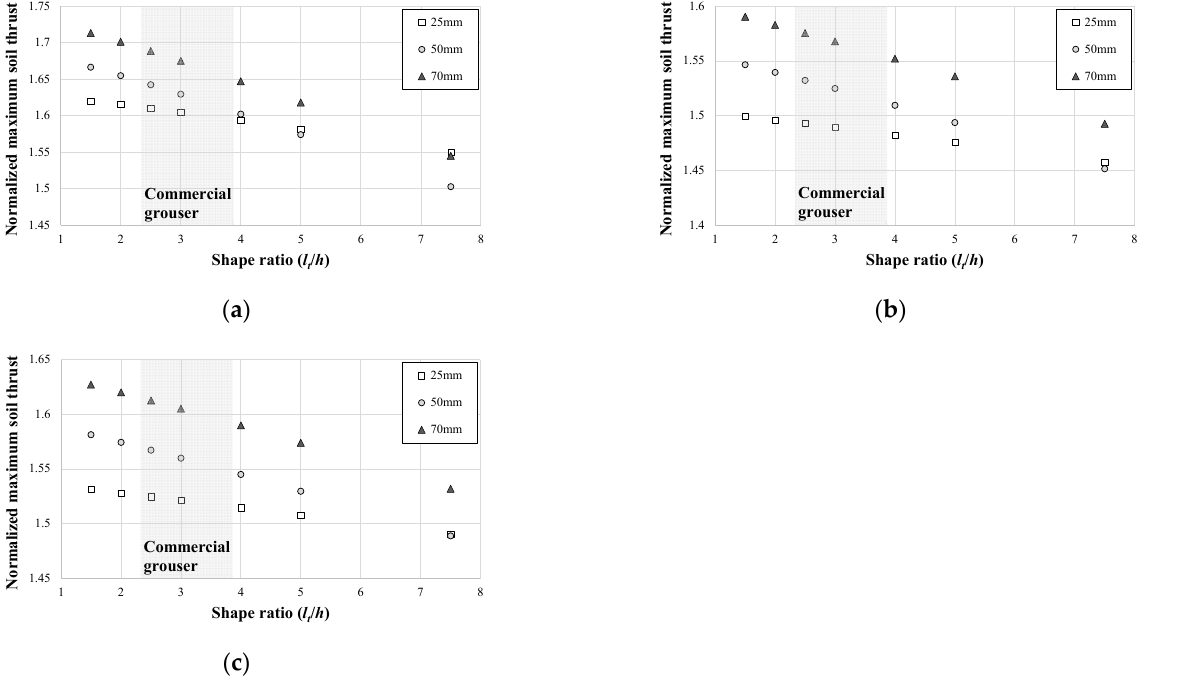
Figure 13. Normalized maximum soil thrust and shape ratio relationships of EC380E: ( a ) hardening behavior, ( b ) softening behavior and ( c ) hump behavior.